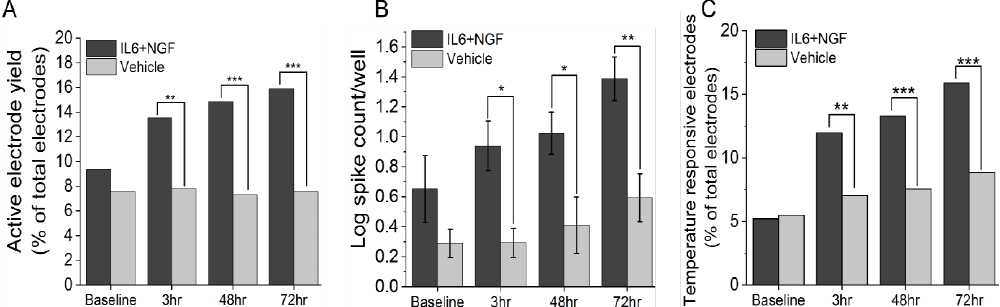
Figure 1. IL-6 and NGF induce an acute and persistent increase in excitability and thermally mediated evoked responses in adult DRG neurons in vitro. ( A ) Percentage of active electrodes post treatment with 100 ng / mL IL6 + 100 ng / mL NGF or vehicle over 3–72 hours period. ( B ) Log spike count per well post treatment over a 3–72 hours period. ( C ) Percentage of temperature responsive electrodes post treatment over a 3–72 hours period. Responsiveness to temperature was defined as an electrode exhibiting a mean firing rate (MFR) of ≥ 2× that of baseline. Temperature stimulus was introduced in the form of base plate heating to a temperature of 42 °C and held for a period of 5 min. An active electrode was defined as an electrode exhibiting a mean firing rate (MFR) of at least 1 spike/min. Error bars are represented as mean ± standard error of the mean (SEM). * p < 0.05, ** p < 0.01, and *** p <0.001.